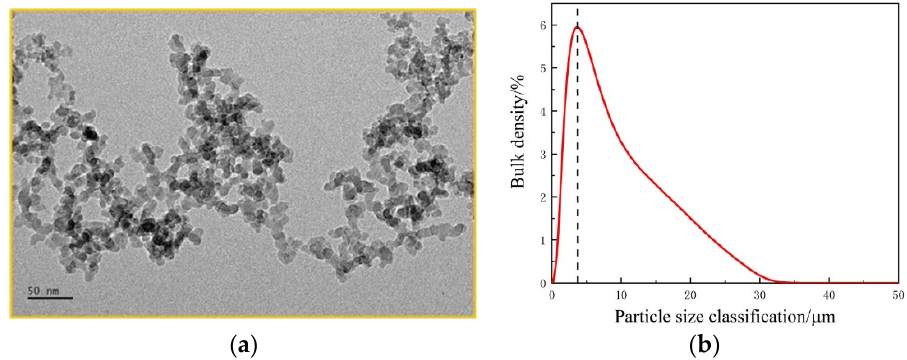
Figure 2. Analysis of experimental materials. ( a ) The photo of TEM. ( b ) Particle size distribution of experimental dust sample.